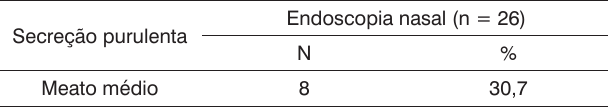
Figura 5. Distribuição da análise microbiológica dos aspirados do seio maxilar. Tabela 4. Análise da evolução clínica após a cirurgia funcional dos seios